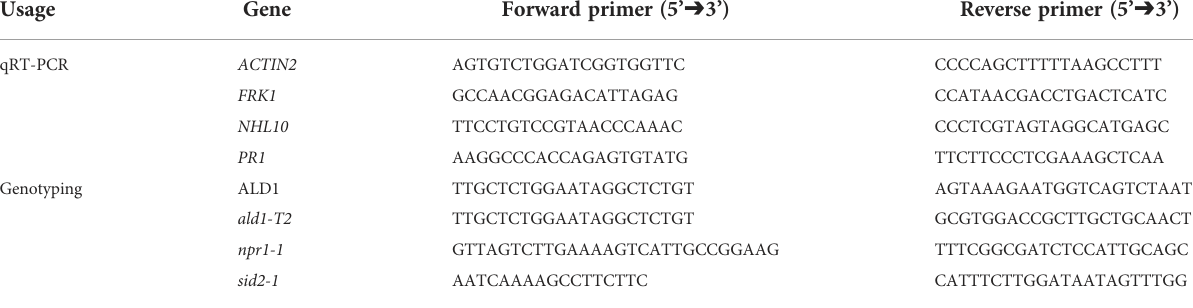
TABLE 1 Nucleotide sequences of primers used in this